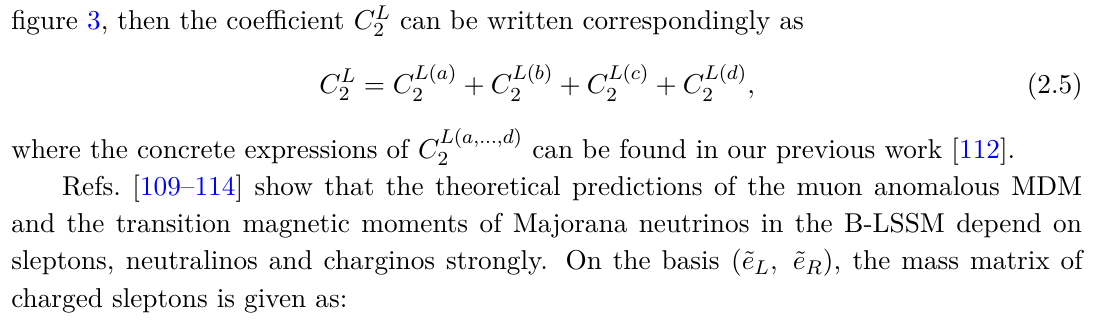
Figure 3 . The one-loop diagrams which contribute the Majorana neutrinos transition magnetic moments, where ˜ L denotes charged slepton, χ ± denotes chargino, l denotes charged lepton. to the transition magnetic moments of Majorana neutrinos in the B-LSSM are plotted